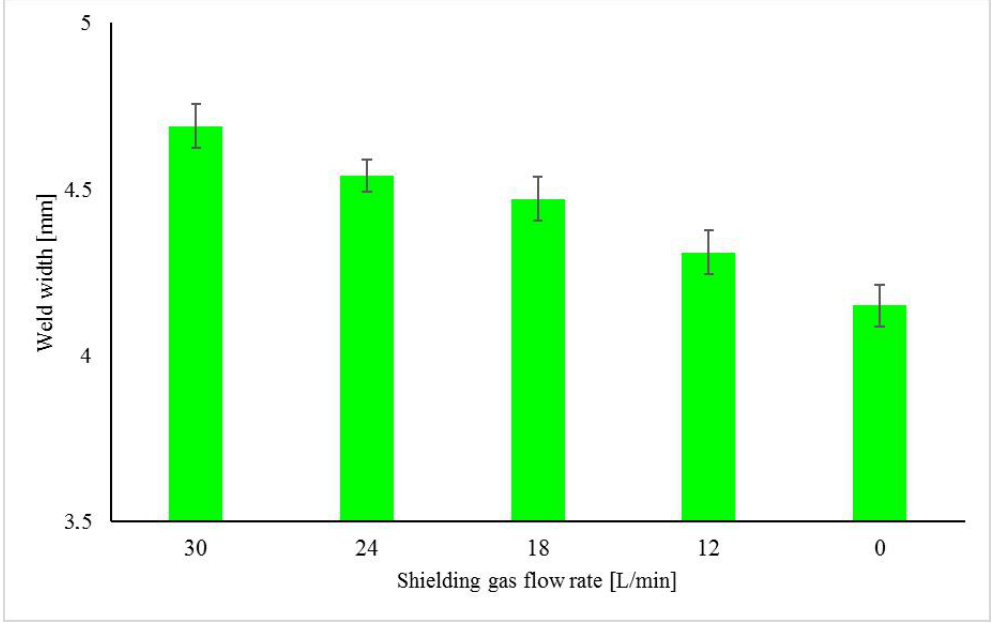
Figure 4. The effect of the gas flow rate on the weld width. Figure 4. The e ff ect of the gas flow rate on the weld